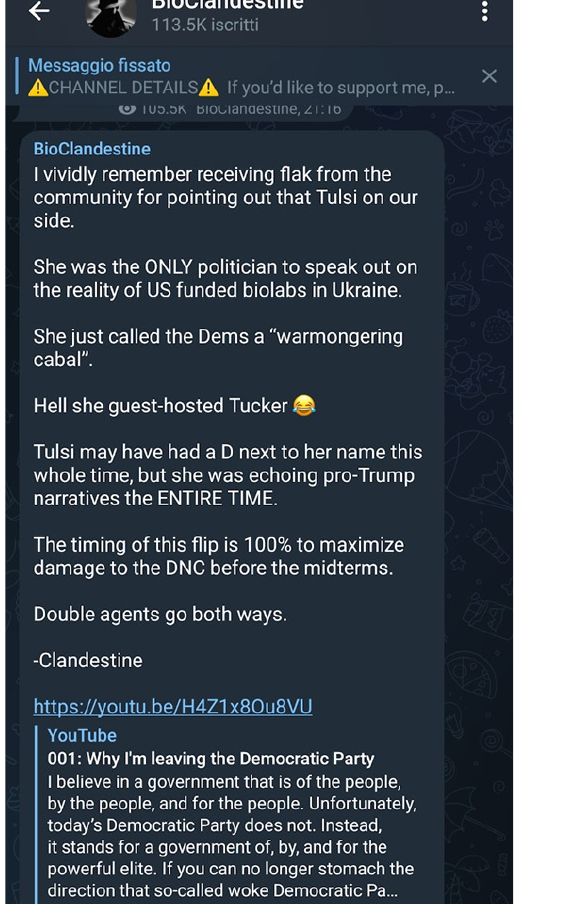
Figure 6. Bioclandestine: Double agents. Access to a truer truth is determined not by the knowl‐ edge itself but by how the secret is disseminated, which appears more authentic precisely because it takes the form of an